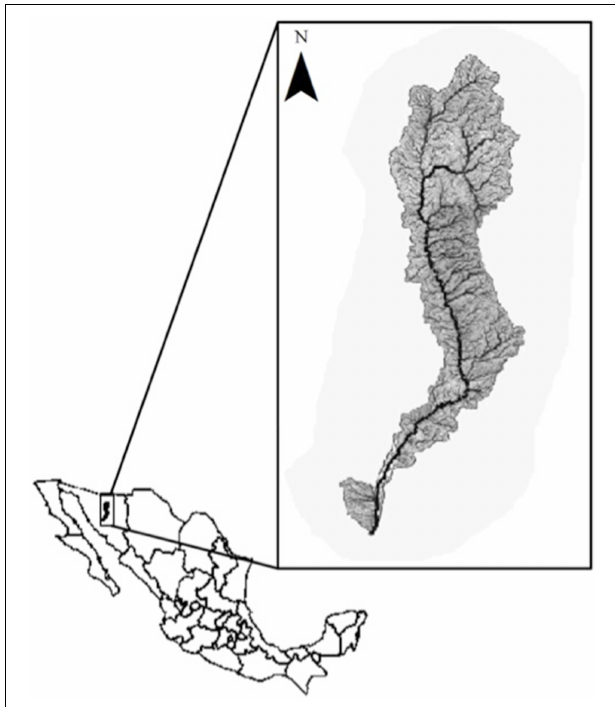
FIGURE 1 | The Rio Sonora Watershed lies within the Mexican state of